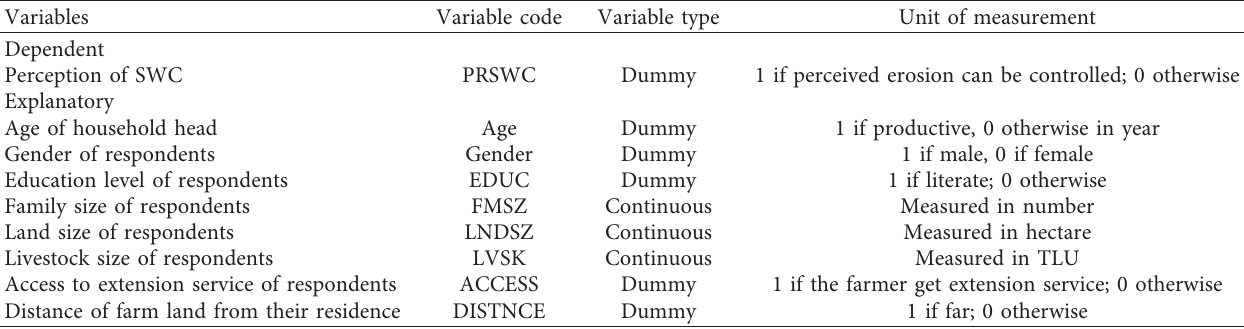
Table 1: Definition and units of measurement of the variables included in the model (n � 117).